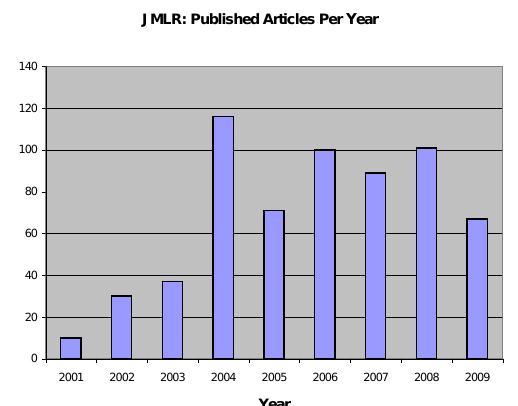
Figure 1: A stabilizing number of published articles for the Journal of Machine Learning Research.